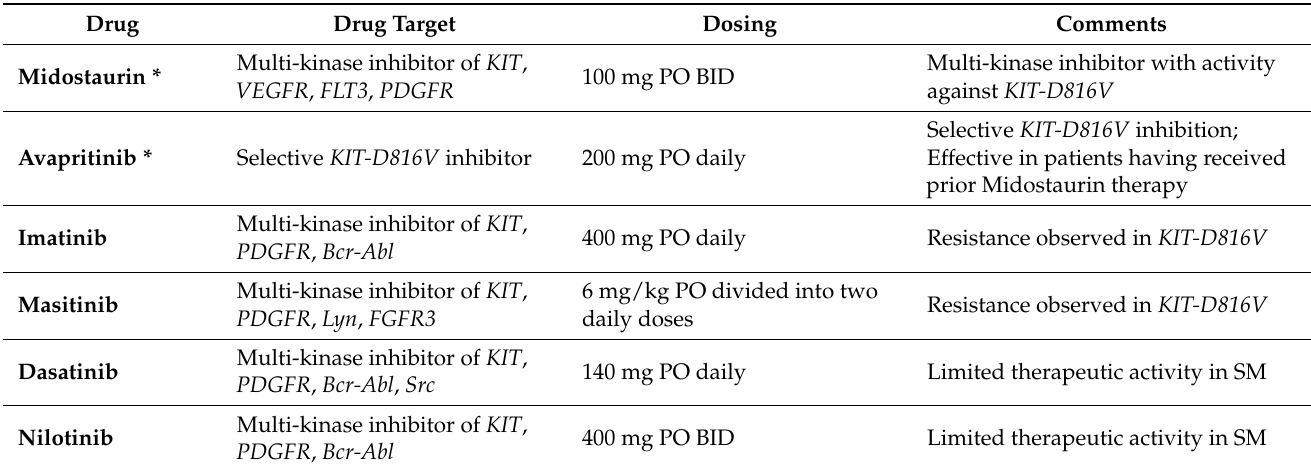
Table 3. Tyrosine kinase inhibitors used in Mast Cell